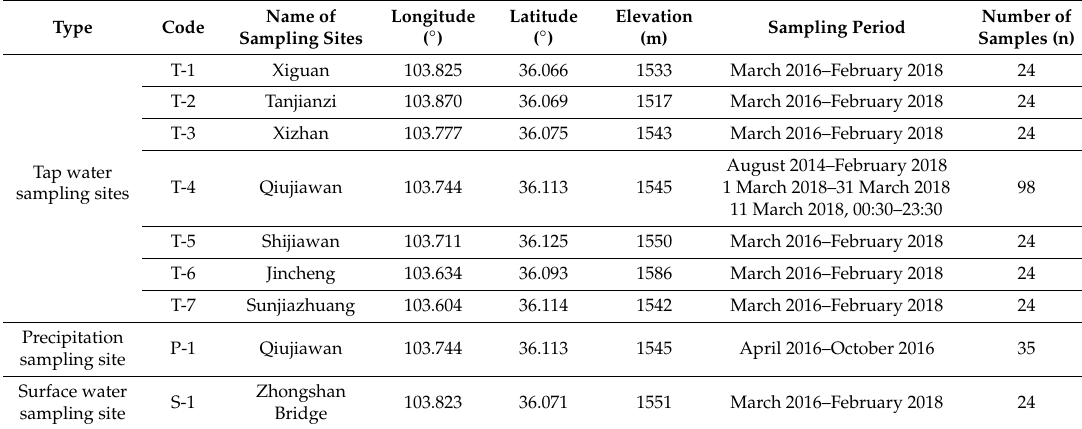
Figure 1. Spatial distribution of sampling sites of tap water, precipitation and surface water in Lanzhou. Table 1. Information of sample sites of tap water, precipitation and surface water in Lanzhou.